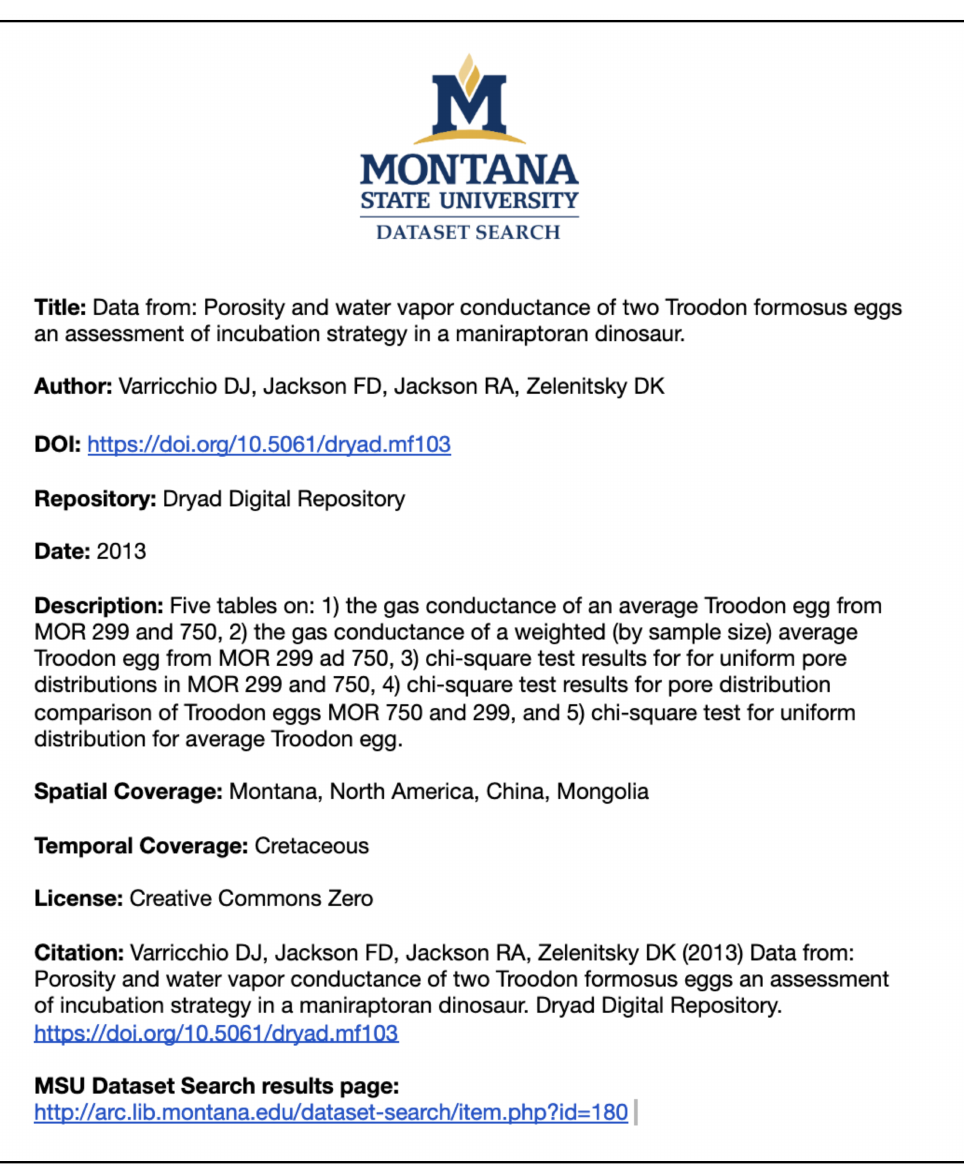
Figure 8. A mockup of a sample PDF dataset cover